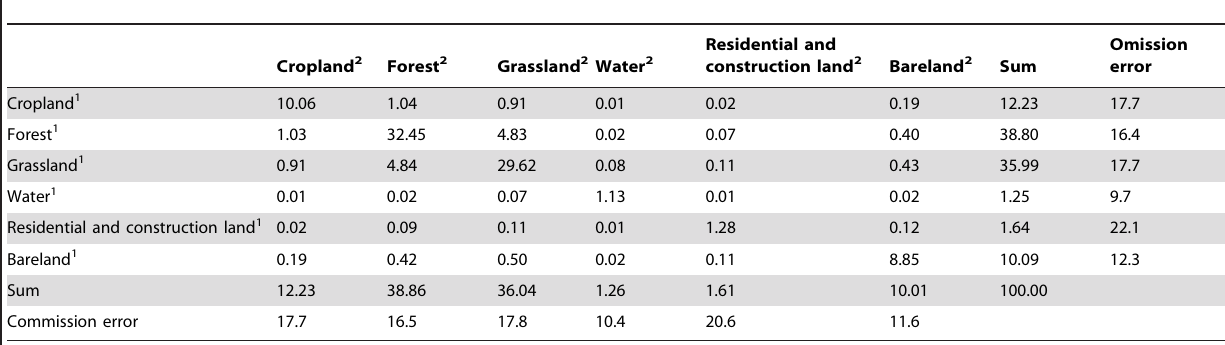
Table 5. Error matrix of the combination model (60%,